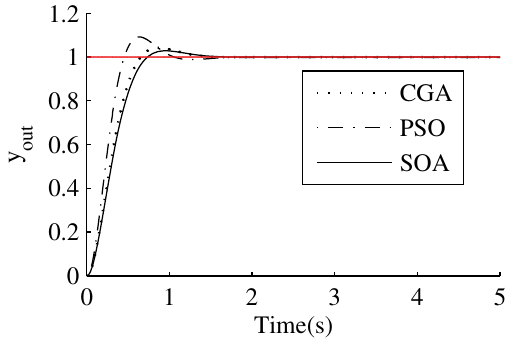
Figure 2. Average convergence curves of objective function